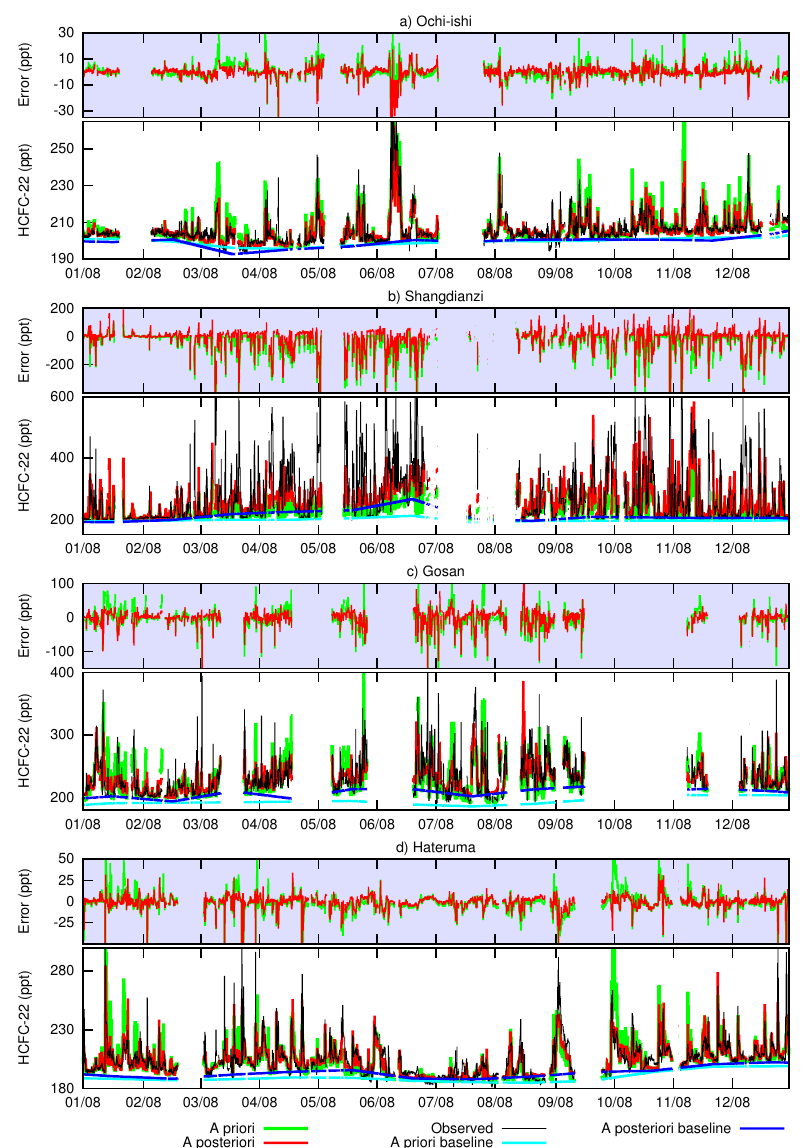
Fig. 2. HCFC-22 time series for (a) Ochi-ishi, (b) Shangdianzi, (c) Gosan, and (d) Hateruma. For every station, the lower panels show the observed (black lines) as well as the modeled mixing ratios using the a priori emissions (green lines) and the a posteriori emissions (red lines), the a priori baseline (cyan lines), and the a posteriori baseline (blue lines). The upper panels show the model errors based on the a priori emissions (green lines) and the a posteriori emissions (red